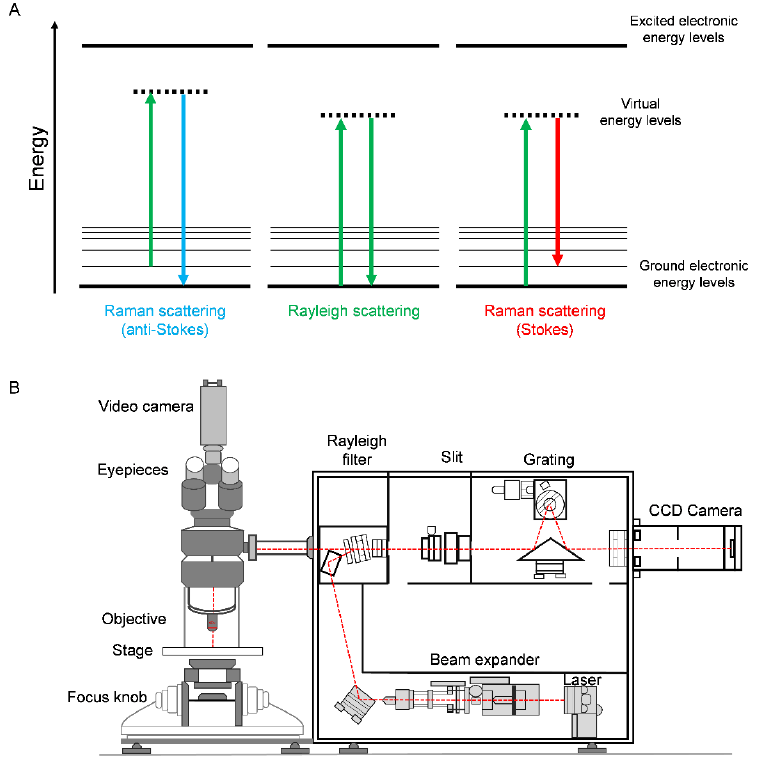
Figure 1. Applications of Raman spectroscopy in prostate cancer disease. ( A ) Energy level diagrams for light scattering. In Rayleigh scattering, photons are scattered with the same energy, and hence frequency, as the incident photons. Raman scattering results in an energy transfer from the incident photons to the chemical bond (Stokes Raman scattering) or from the vibrationally excited chemical bonds to the incident photons (anti-Stokes Raman scattering). Thus, Stokes Raman scattering results in photons with a lower energy than the incident photons, whilst anti-Stokes Raman scattering results in photons of a higher energy than the incident photons. ( B ) A schematic diagram of a Raman microscope. Raman microscopes consist of the following components: a laser source generating monochromatic light, a microscope setup with an objective lens to focus the laser beam and sample stage to enable mapping of the sample (the objective lens also collects the Raman scattered photons in backscattering configuration), a Rayleigh filter to remove the Rayleigh scattered light (the excitation wavelength), a pinhole for confocal sectioning of the target sample which removes out-of-focus light, a diffraction grating which separates the photons according to wavelength, and typically, a charge couple device (CCD) detector to capture the intensity of photons at each